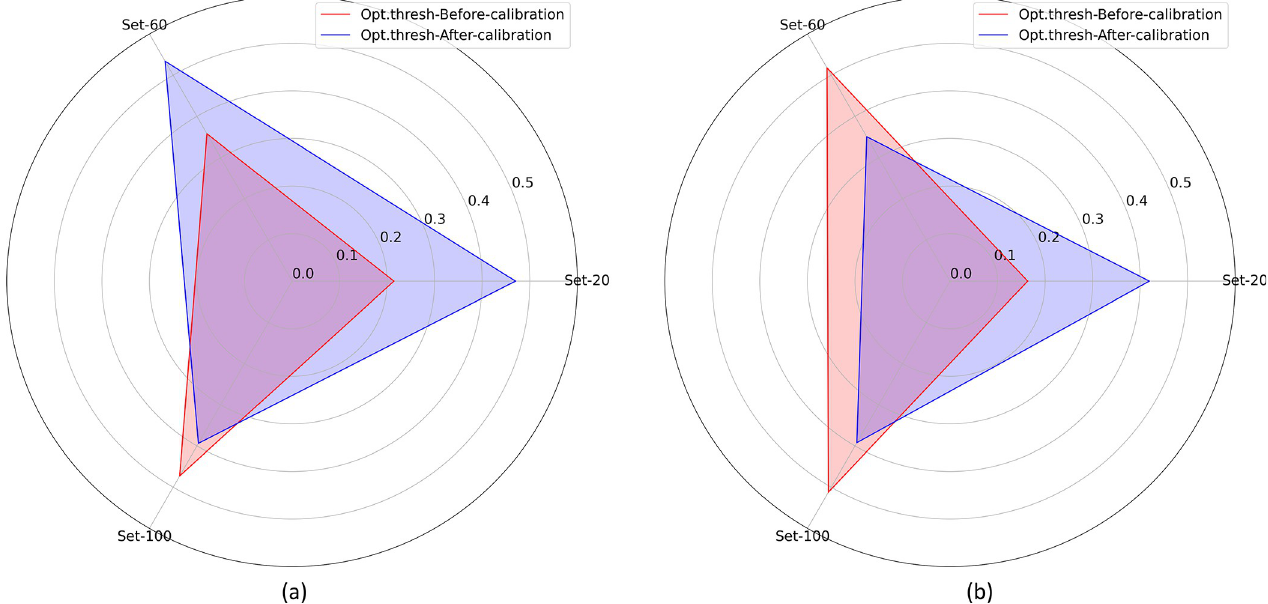
Fig 8. Polar coordinates plot showing the optimal threshold values identified from the PR curves using uncalibrated and calibrated probabilities generated from Set-20, Set-60, and Set-100 datasets for (a) APTOS’19 fundus and (b) Shenzhen TB CXR data collections. https://doi.org/10.1371/journal.pone.0262838.g008 Fig 8 and Table 5 summarize the optimal threshold values identified from the PR curves using the uncalibrated and calibrated probabilities. The probabilities are calibrated using the best-performing calibration method as reported in Table 3. The polar coordinates plot shown in Fig 8 illustrates a difference in the optimal threshold values obtained before and after calibration. It is observed from Table 5 that the optimal threshold values are significantly different ( p < 0.05) for the uncalibrated and calibrated prob- abilities obtained across the class-imbalance simulated datasets. The observation holds for both APTOS’19 fundus and Shenzhen TB CXR data collections. Fig 9 shows the PR curves with their optimal thresholds, obtained using the uncalibrated and calibrated probabilities for the Set-20 dataset, constructed from the APTOS’19 fundus and Shenzhen TB CXR datasets. The PR curves for other class-imbalance simulated datasets are shown in S6 Fig. The perfor- mance obtained at these optimal threshold values is summarized in Table 6 and S7 Fig. It is evident from the polar coordinates plot shown in S7 Fig that, at the optimal threshold values derived from the PR curves, there is no significant difference in the MCC values obtained